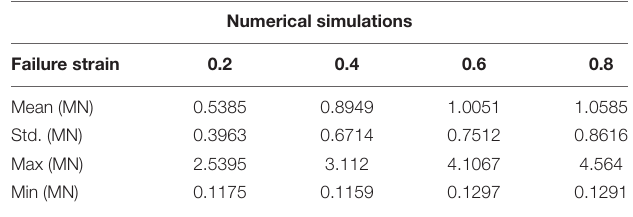
TABLE 6 | Comparison of the ice forces in the simulations with different failure